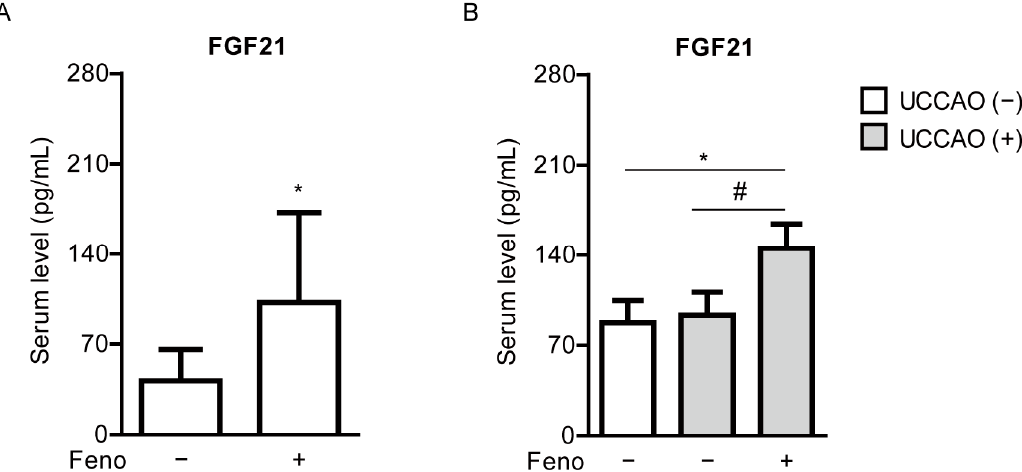
Figure 5. Increases in serum levels of FGF21 by oral administration of fenofibrate in adult mice. ( A ) Quantitative analyses ( n = 7–8 per group) show that oral administration of fenofibrate significantly increased FGF21 levels in the blood 4 days after oral administration of fenofibrate, right before UCCAO. * p < 0.05 (Student’s t -test). ( B ) Quantitative analyses ( n = 6 per group) show that oral administration of fenofibrate increased FGF21 levels in the blood 12 days after UCCAO. * p < 0.05 (one-way ANOVA), # p < 0.05 (Student’s t -test). The data were analyzed using Student’s t -test (two-tailed) or one-way ANOVA followed by a Bonferroni post hoc test and presented as mean ± standard deviation. Feno; fenofibrate. UCCAO; unilateral common carotid artery occlusion.